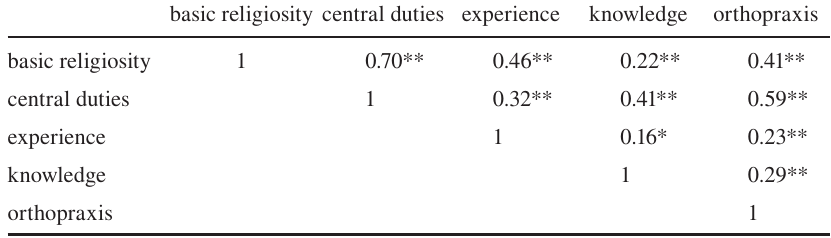
Correlation Matrix of the five dimensions of Muslim